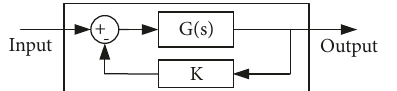
Figure 3: Structure of controlled object with feedback.